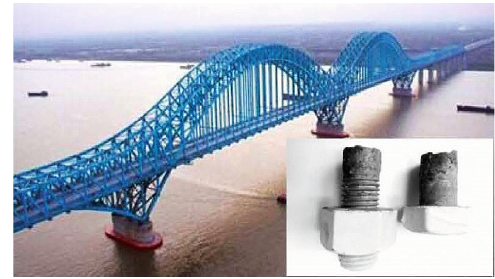
Figure 1. The Dashengguan Railway Bridge and bolt